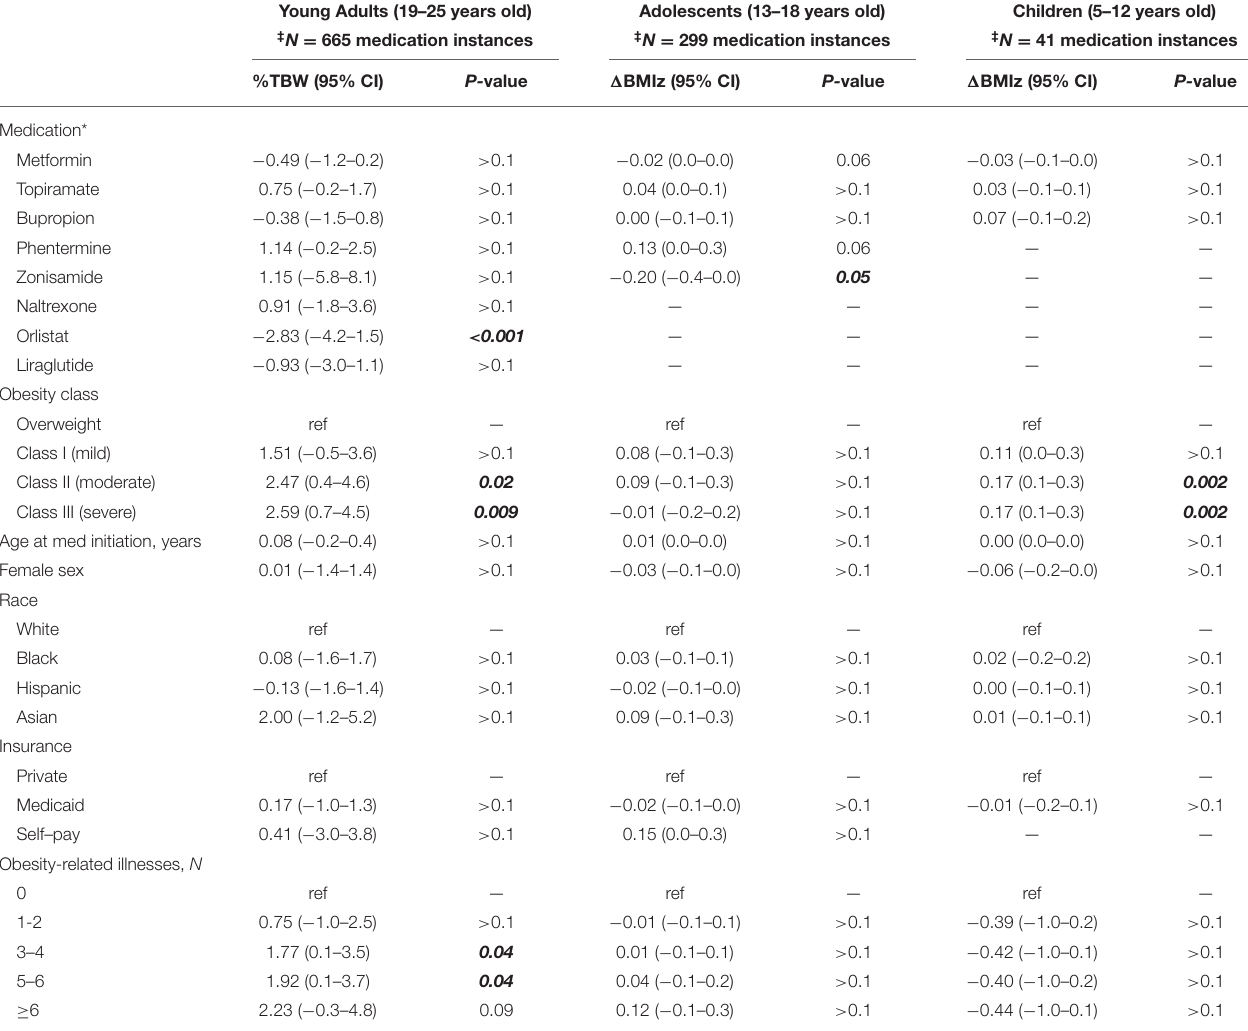
TABLE 6 | Effect on maximum weight loss, all patients—adjusted